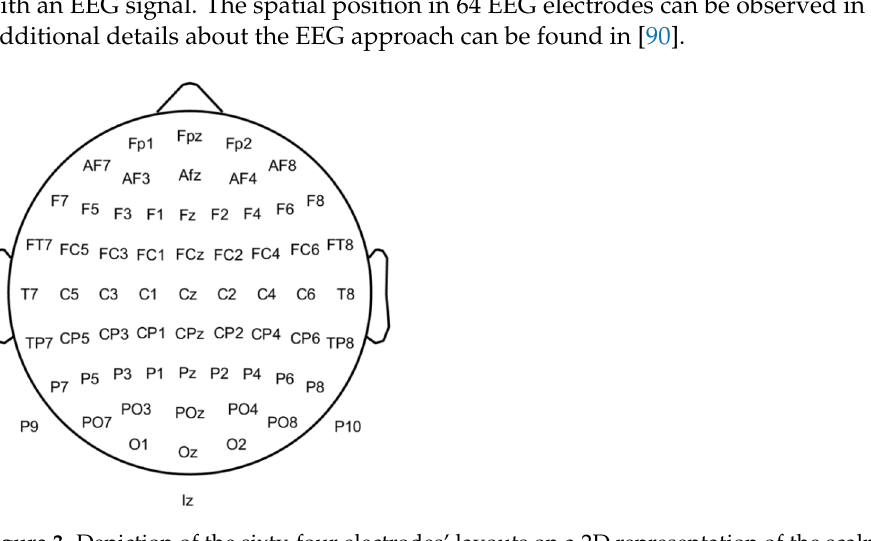
Figure 3. Depiction of the sixty-four electrodes’ layouts on a 2D representation of the scalp. To explain the underlying abnormalities in patients diagnosed with schizophrenia, a tional magnetic resonance imaging (fMRI), EEG, and structural magnetic resonance im- aging (sMRI) parameters. In the work of Shim et al. [80], three sets of parameters were used: sensor-level parameters (124 parameters), source-level parameters (314), and a com- bination of both.